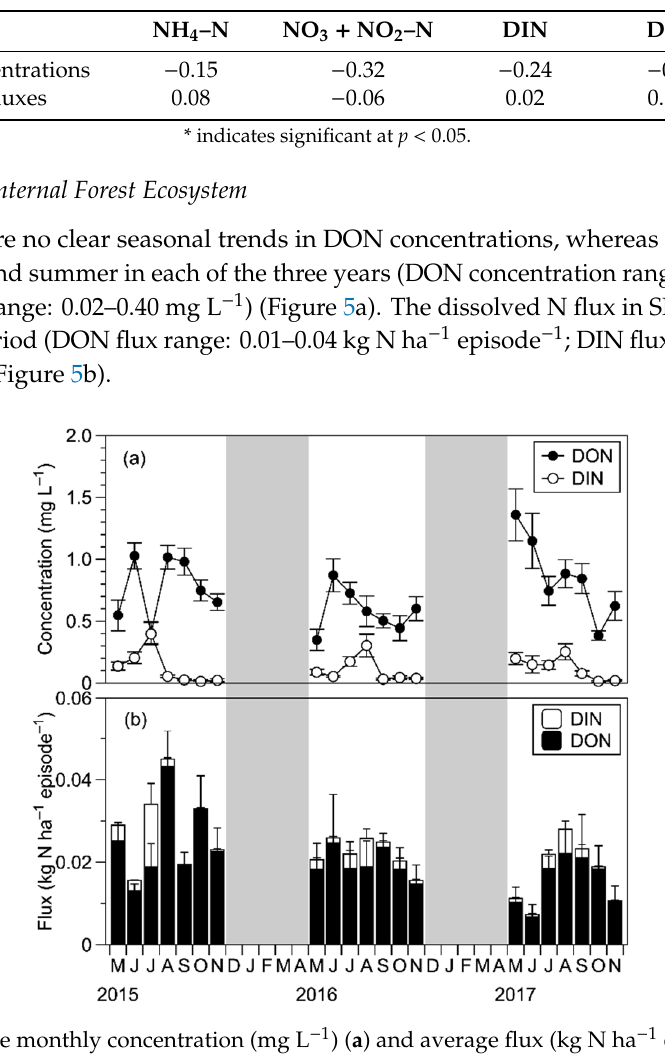
Figure 5. Average monthly concentration (mg L − 1 ) ( a ) and average flux (kg N ha − 1 episode − 1 ) ( b ) of dissolved nitrogen in stemflow from May 2015 to November 2017. Shaded areas show the snow seasons. Error bars show the standard error ( n = 9). DON = Dissolved organic nitrogen; DIN = Dissolved inorganic nitrogen.